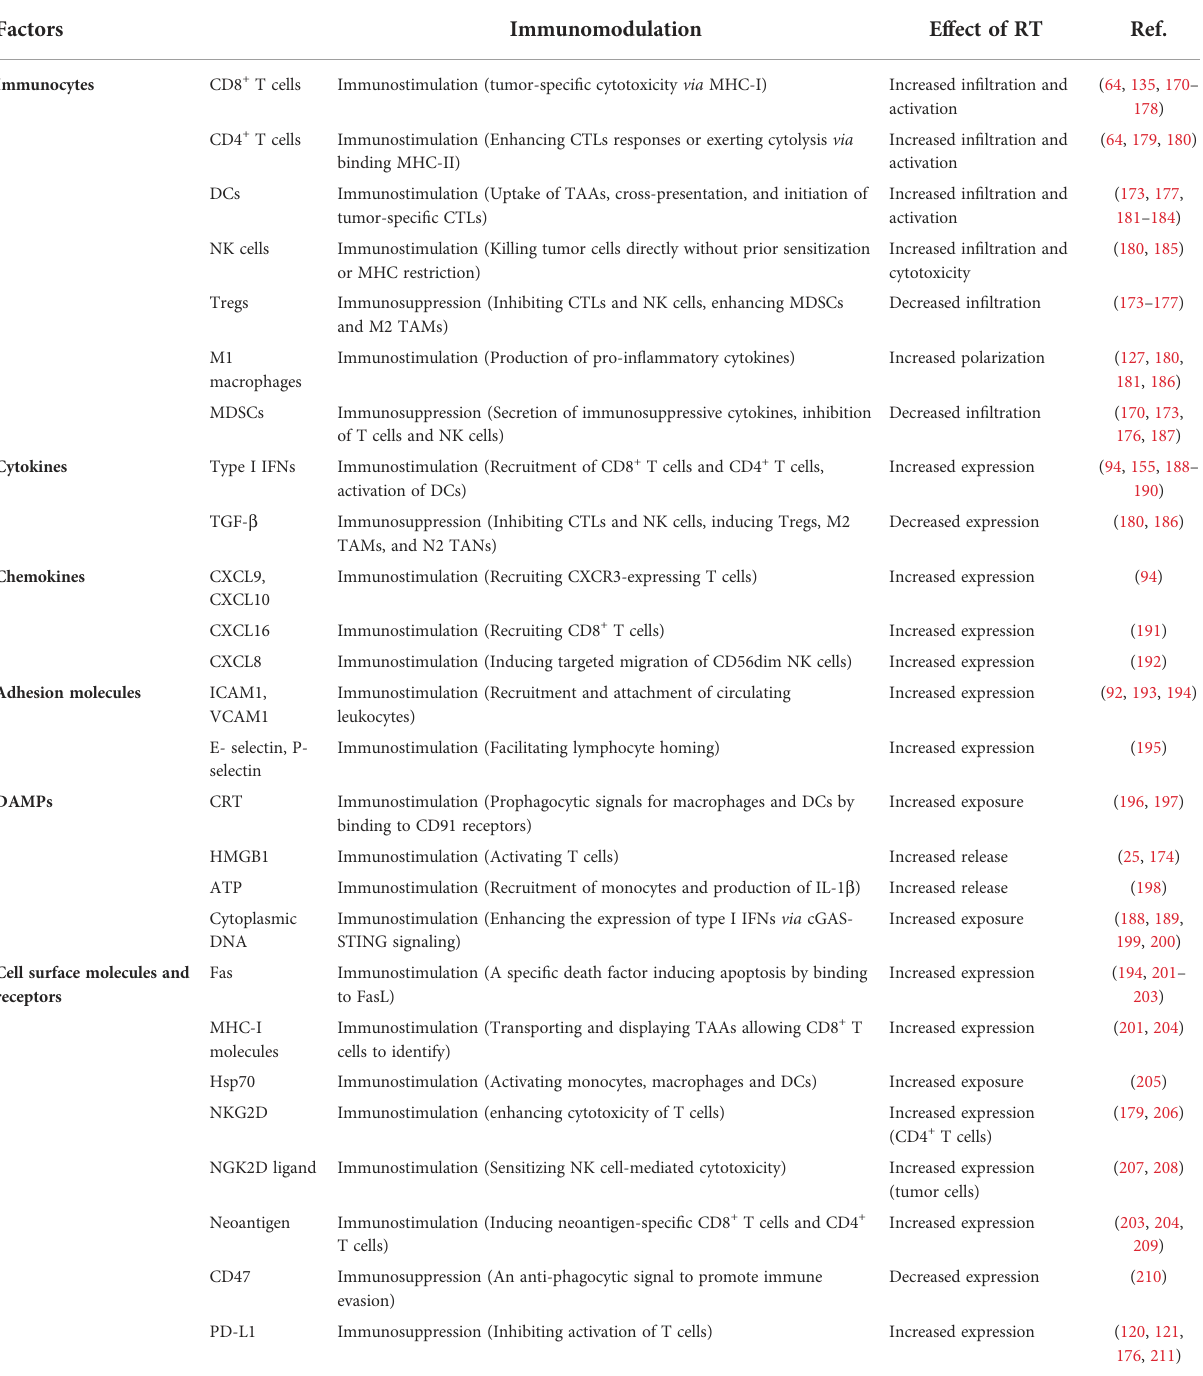
TABLE 1 Summary of alterations in immunomodulatory factors